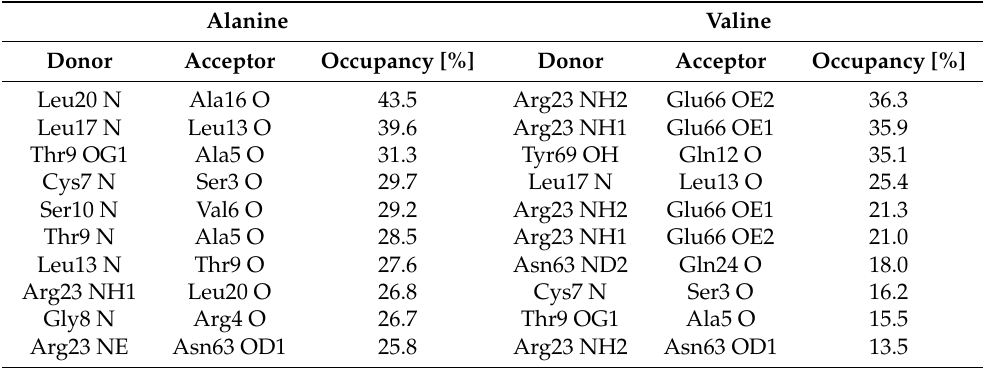
Table 2. The 10 most stable hydrogen bonds formed by the MTS with the rest of the protein or itself sorted based on their occupancy in %. Hydrogen bonds formed with the solvent or ions are not included. All hydrogen bonds formed by the MTS with the rest of the protein or itself are listed in the supplementary material Table